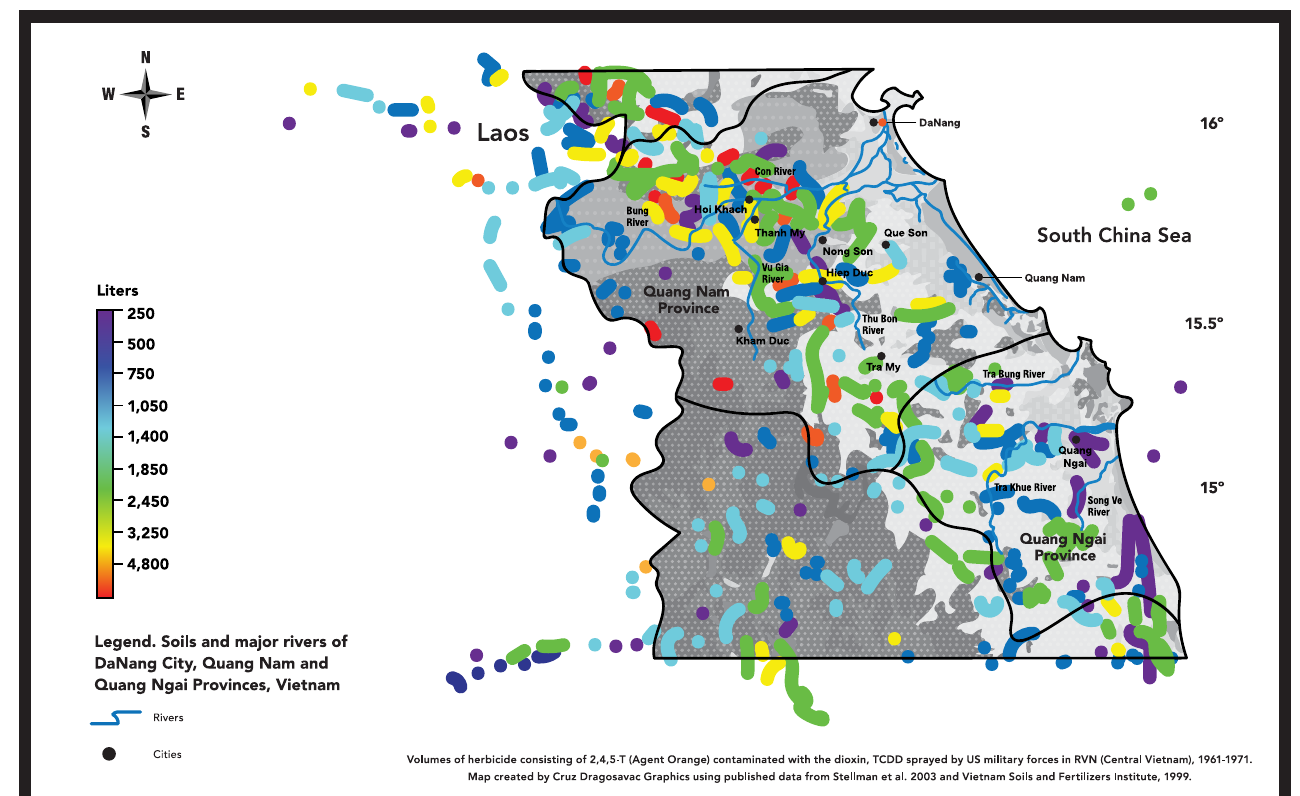
Fig 1. Map of Da Nang City and Vietnam provinces Quang Nam and Quang Ngai in Central Vietnam represents a re-creation of geographic locations of herbicide applications in Vietnam based on Stellman et al (2003) [7] re-estimate of the volume of Agent Orange and other 2, 4, 5-T formulations sprayed between 1961 and 1971 in the Da Nang region. The color scale to the left of the map shows increasing volume of herbicide sprayed (250 liters to more than 4,800 liters in a single location). The background shades of white and gray represent major soils groups and rivers of Da Nang, Quang Nam and Quang Ngai provinces. Lighter background shades are lowlands and upland valley locations where soils are better suited to grow agricultural crops and rural population densities are likely to be higher. Map created by Dragosavac Graphics.